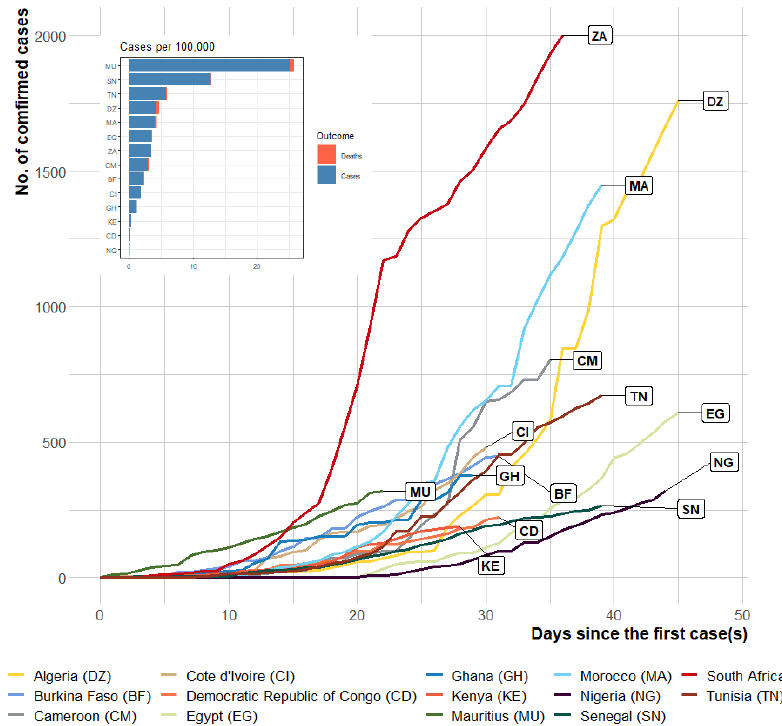
Figure 2. The number of confirmed cases in the first 45 days of COVID-19 importation to selected African countries. Inset: cases per 100,000 population as of 11 April 2020.